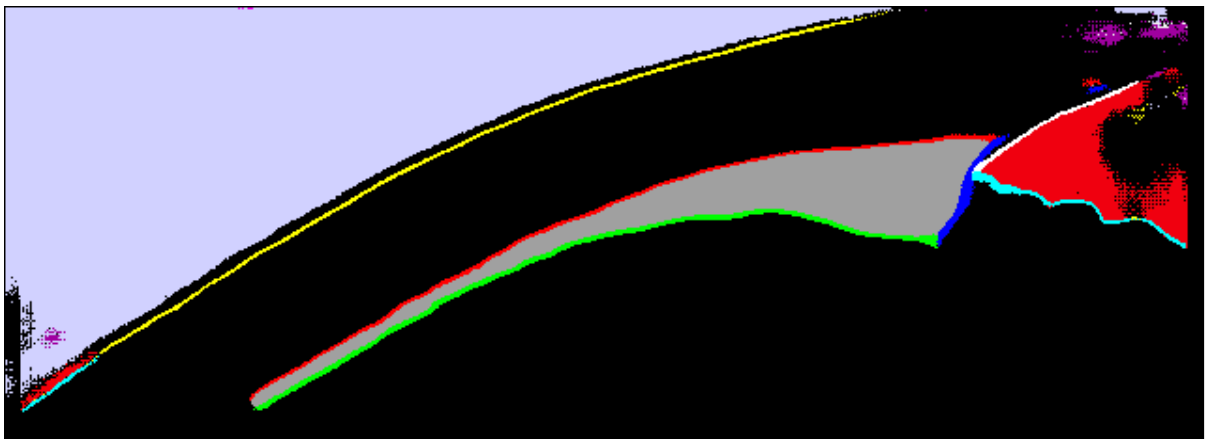
Figure 3. An exemplary result of the segmentation of an OCT image of the ciliary muscle performed by Ciloctunet . The colors correspond to the segmentation classes listed in Table 1. There are several wrong classifications, however, most of them only affect areas that are not used for further pro- cessing.